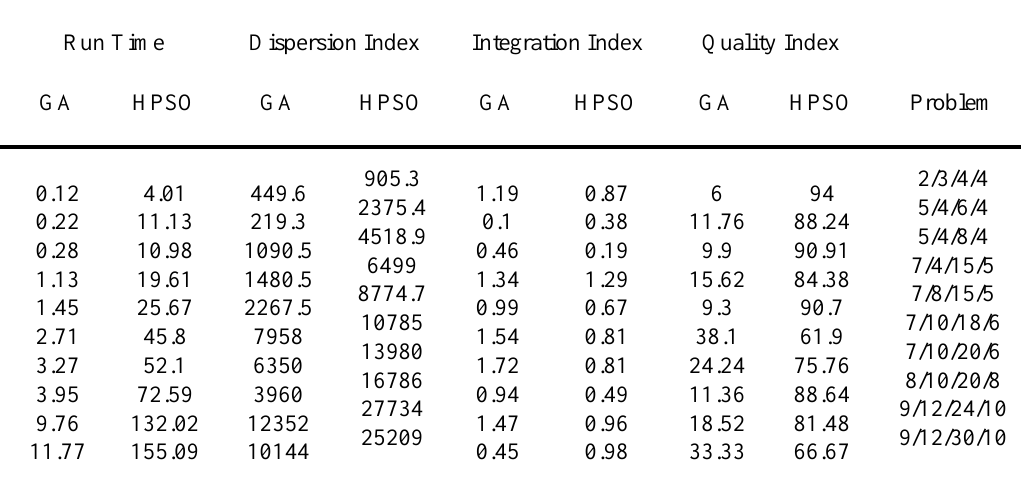
Table 1. Comparison results for genetic algorithm (GA) and Hybrid Particle Swarm Optimization Algorithm